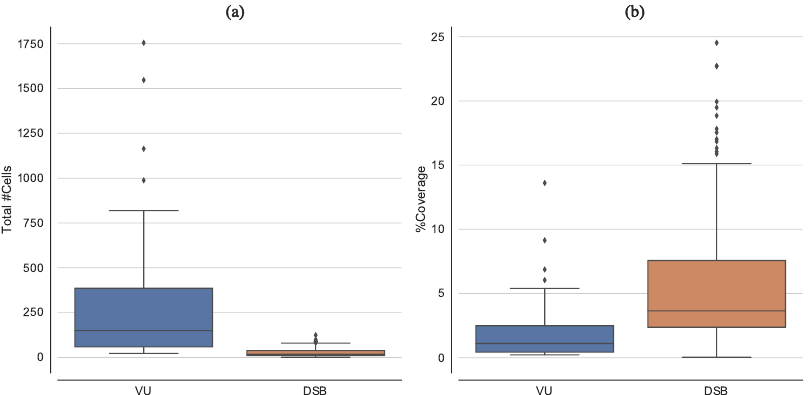
Figure 3. Boxplots depicting the distribution for both the analyzed datasets in terms of: ( a ) total number of cells, and ( b ) coverage of the cell nuclei